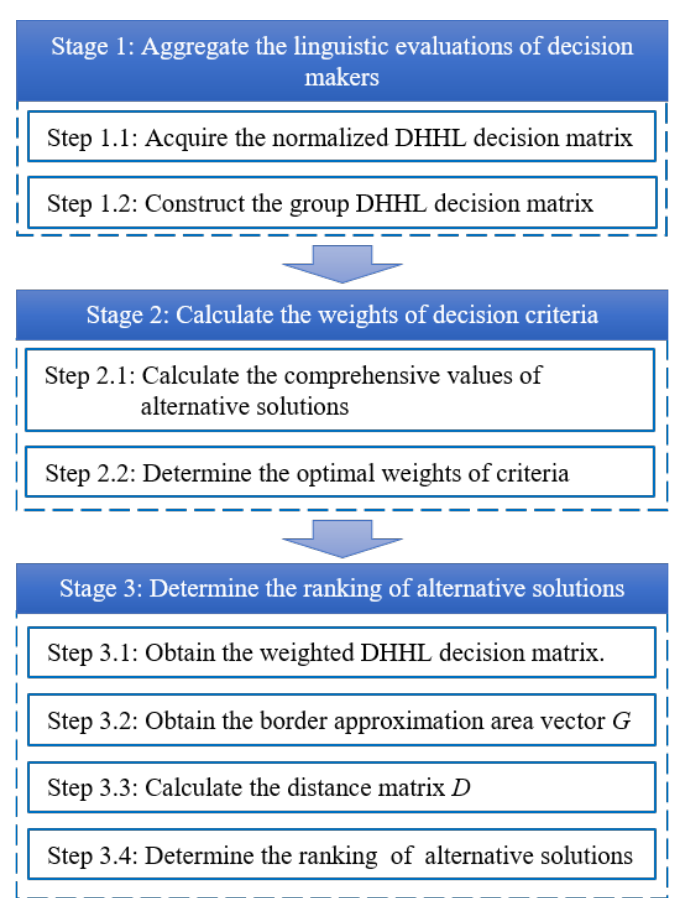
Figure 1. The flow diagram of the proposed EDM model.